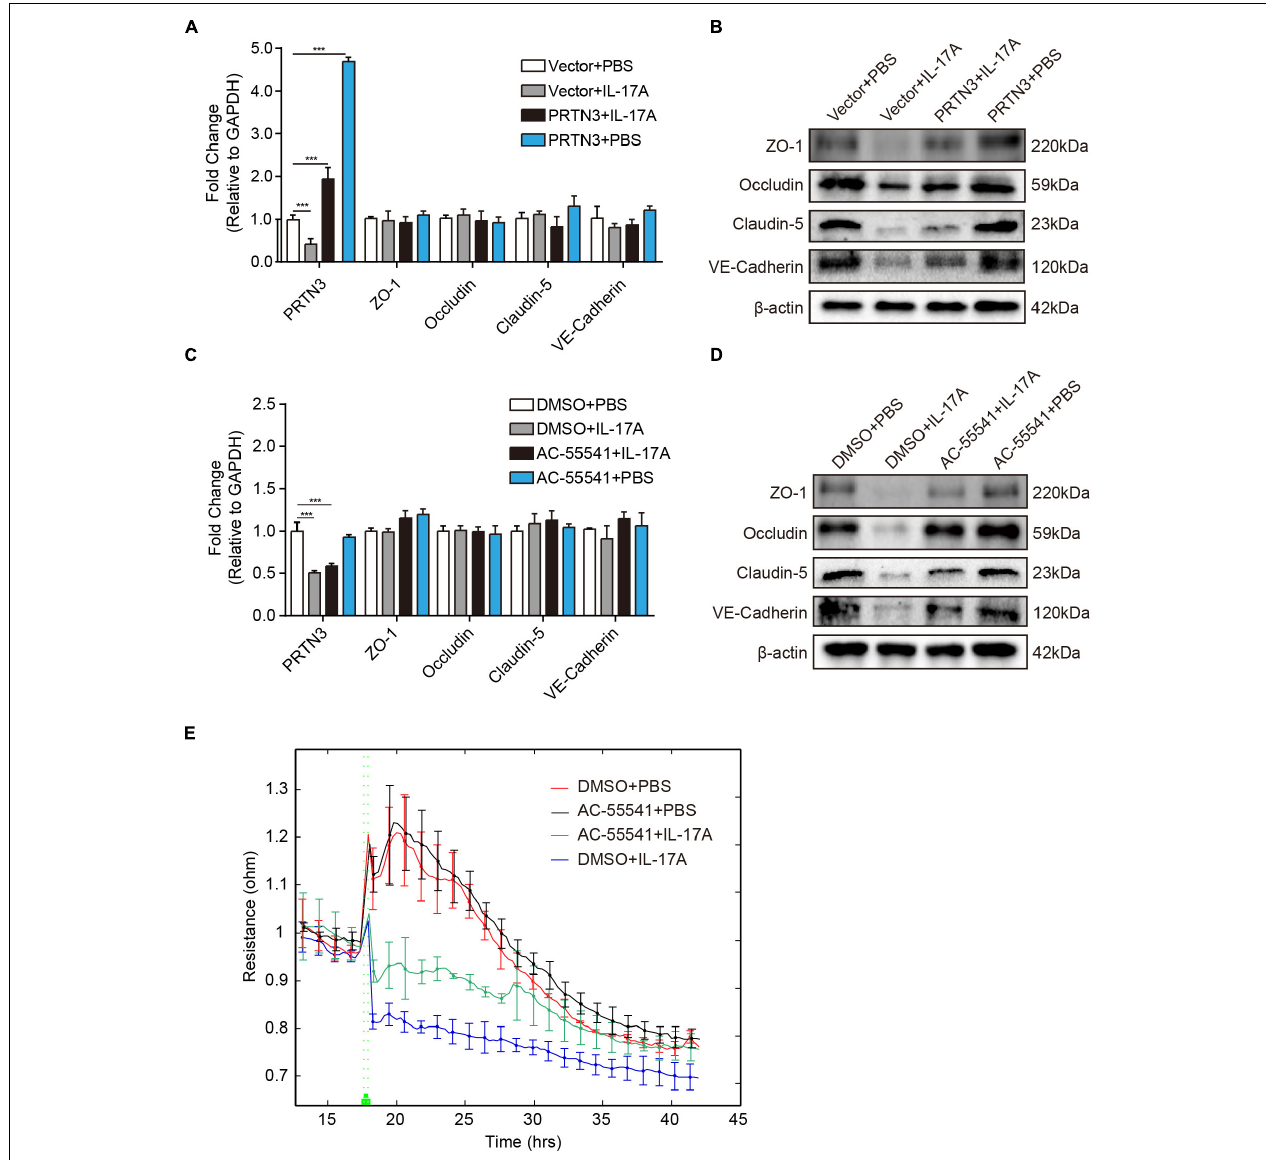
FIGURE 5 | Interleukin-17A disrupts TJs and AJs by inhibiting PRTN3/PAR-2 axis. (A) The qPCR analysis of ZO-1, Occludin, Claudin-5, and VE-Cadherin extracted from IL-17A untreated hBMECs and IL-17A treated hBMECs with or without the overexpression of PRTN3. GAPDH was used as the internal reference. Data were presented as mean ± SD from three independent experiments. *** p < 0.001 by one-way ANOVA analysis. (B) Western blot of ZO-1, Occludin, Claudin-5 and VE-Cadherin extracted from IL-17A untreated hBMECs and IL-17A treated hBMECs with or without overexpression of PRTN3. β -Actin was used as the loading control. (C) The qPCR analysis of ZO-1, Occludin, Claudin-5, and VE-Cadherin extracted from IL-17A untreated hBMECs and IL-17A treated hBMECs with or without PAR-2 agonist AC-55541. GAPDH was used as the internal reference. Data were presented as mean ± SD from three independent experiments. *** p < 0.001 by one-way ANOVA analysis. (D) Western blot of ZO-1, Occludin, Claudin-5, and VE-Cadherin extracted from IL-17A untreated hBMECs and IL-17A treated hBMECs with or without PAR-2 agonist AC-55541. β -Actin was used as the loading control. (E) TEER changes of the IL-17A untreated hBMECs and